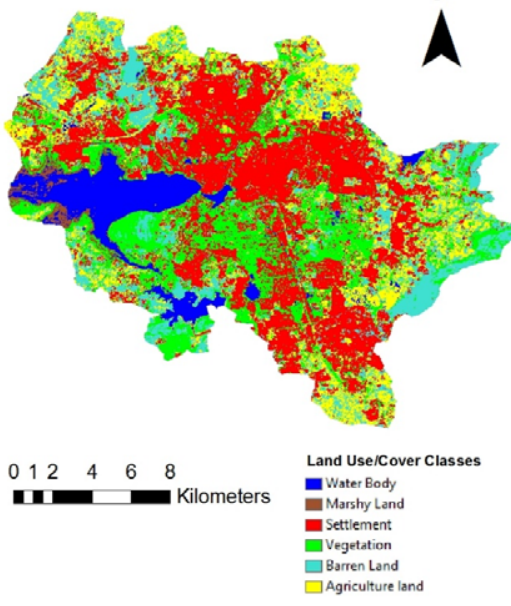
Fig. 2: LULC map of Bhopal